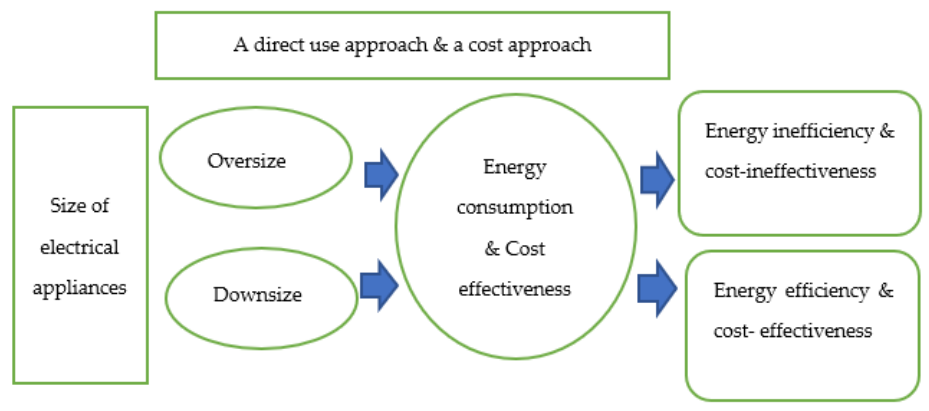
Figure 1. Impacts of electrical appliance sizes on energy consumption.